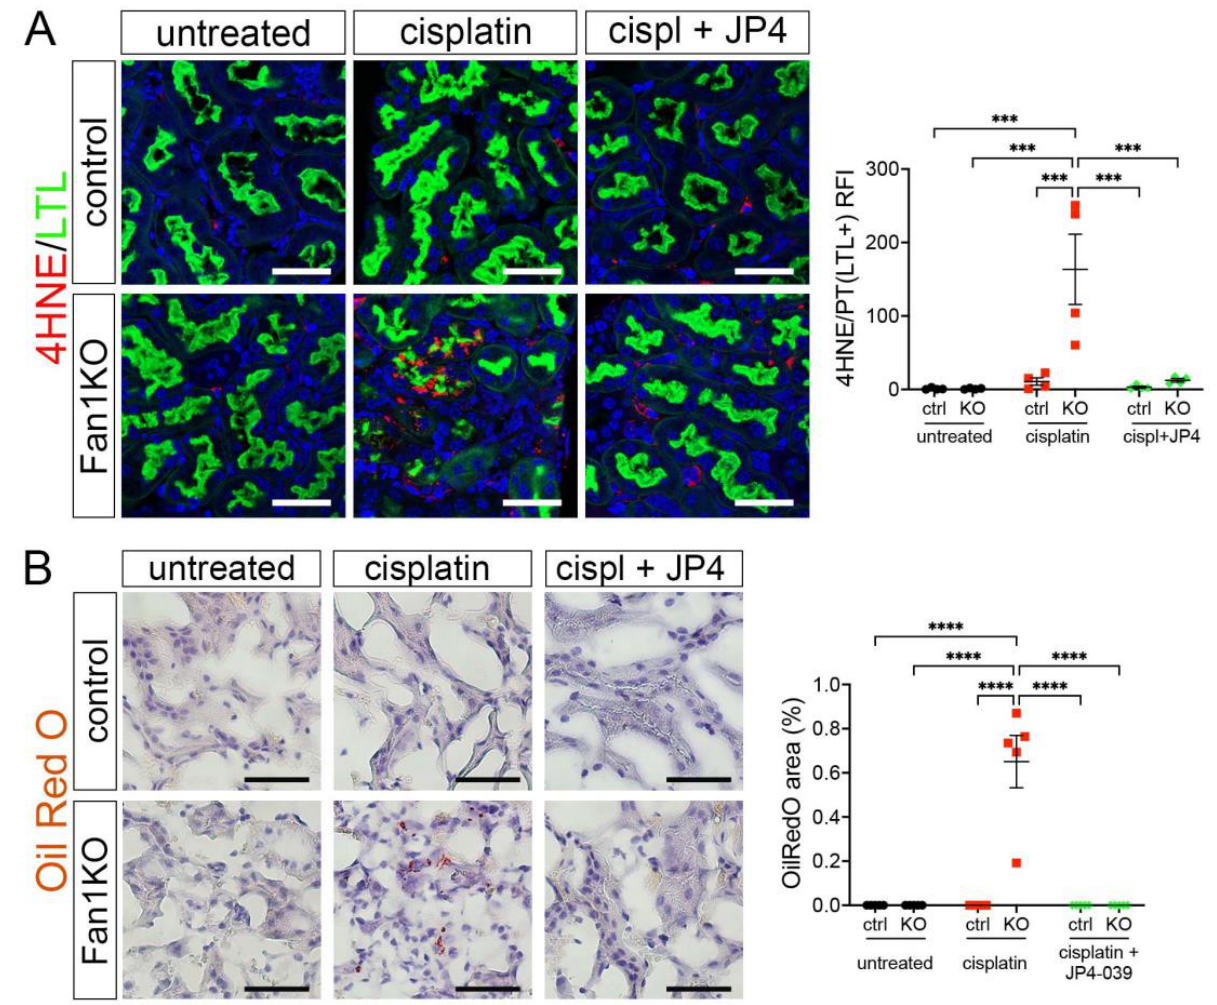
Figure 5. Oxidation stress-induced tubular damage is attenuated by JP4-039. ( A ) Representative images of untreated and cisplatin (2 × 2 mg/kg) ± JP4-039 (10 mg/kg in 50% PEG-400/50% H 2 O) treated control and FAN1KO kidneys stained with antibodies against 4-HNE to mark lipid peroxidation products. *** p < 0.001, n = 4 each. Scale bar: 25 µ m. ( B ) Increased lipotoxicity in injured FAN1KO kidneys as revealed by OilRed O staining. Treatment with JP4-039 reduces lipid accumulation in cisplatin-injured FAN1KO kidneys. **** p < 0.0001, n = 5 each. Scale bar: 50 µ m. ( A , B ) Data are presented as the mean ± SEM. A two-way ANOVA with Tukey’s post hoc